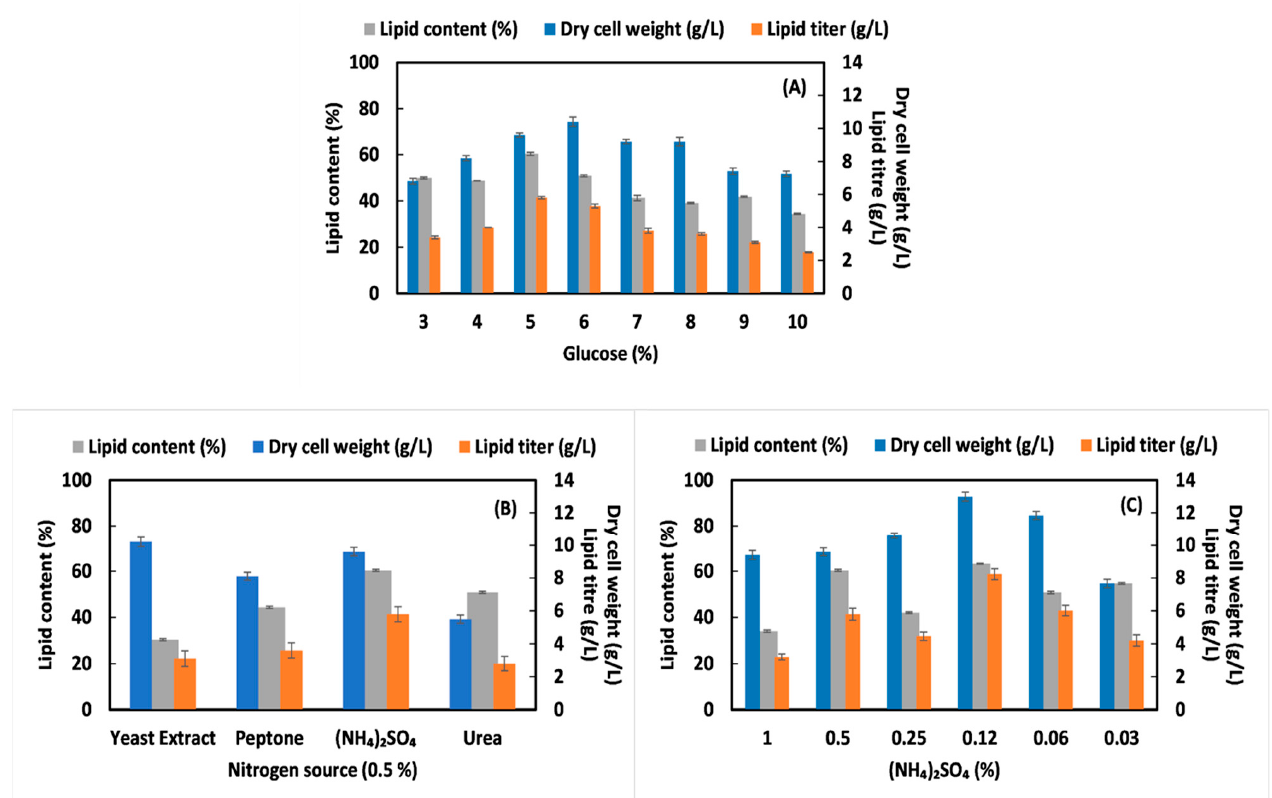
Figure 1. Comparative analysis of dry cell weight (g/L), lipid titer (g/L) and lipid content in R. toruloides at stationary phase using different media compositions ( A ) glucose (3 to 10%); ( B ) nitrogen sources ( C ) (NH 4 ) 2 SO 4 (1 to 0.03%).